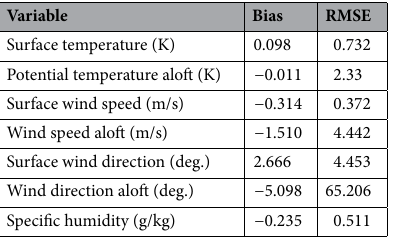
Table 2. Bias and root mean square error (RMSE) values associated with evaluation of the generated WRF meteorology (domain1) against surface observations and observations